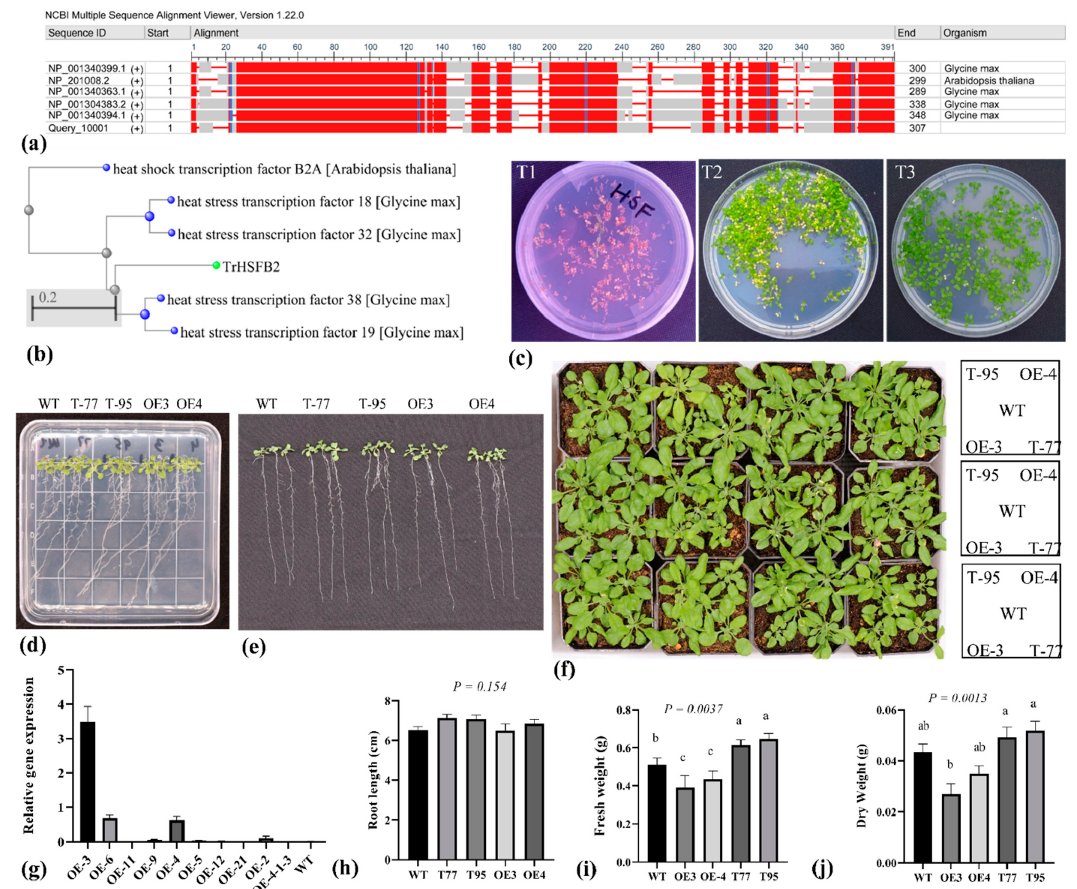
Figure 4. Homologous relationship of TrHSFB2a based on conserved domains and construction of overexpression lines of TrHSFB2a . ( a ) Homologous relationship of TrHSFB2a with most related proteins, with most conserved regions shaded by red color ( b ) Phylogenetic relationship of TrHSFB2a based on conserved domains, ( c ) selection of overexpression lines of TrHSFB2a on 1/2MS medium containing 50 mg/L Kanamycin for developing homozygous lines. Only transformed plant could grow on selection media, while non-transformed turned into yellow and died ( d , e ) Show plant stature and root growth of wild type (Wt), RNA interference T-DNA lines (T-77 and T-95) and overexpression lines (OE3 and OE4) grown on 1/2MS medium containing 3% sucrose and 0.7% agar. ( f ) Display the morphology of TrHSFB2a overexpression lines, T-DNA lines and Wt type plants in soil, ( g ) relative gene expression in overexpression lines, ( h , i and j ) display root length (cm), fresh weight (g) and dry weight (g), respectively, of wild and transgenic plants under normal growth condition . Bars represent mean ± SD values, and different small letters (a, b and c) represent significant statistical difference among means (one-way ANOVA, followed by Tukey test) between different lines.